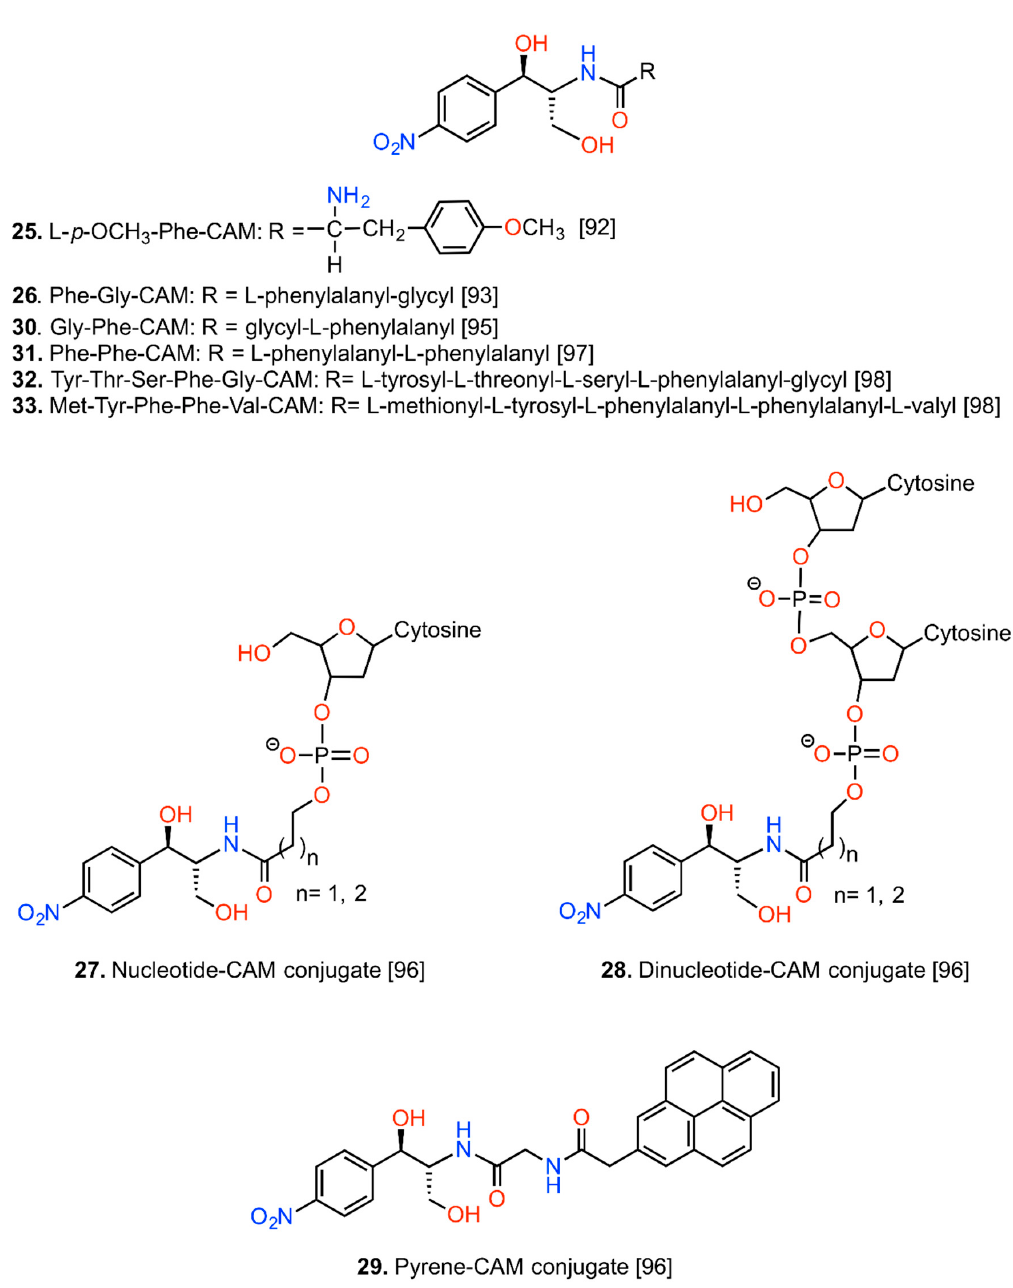
Figure 8. Conjugates of CAM with amino acids, peptides, nucleotides and pyrene.